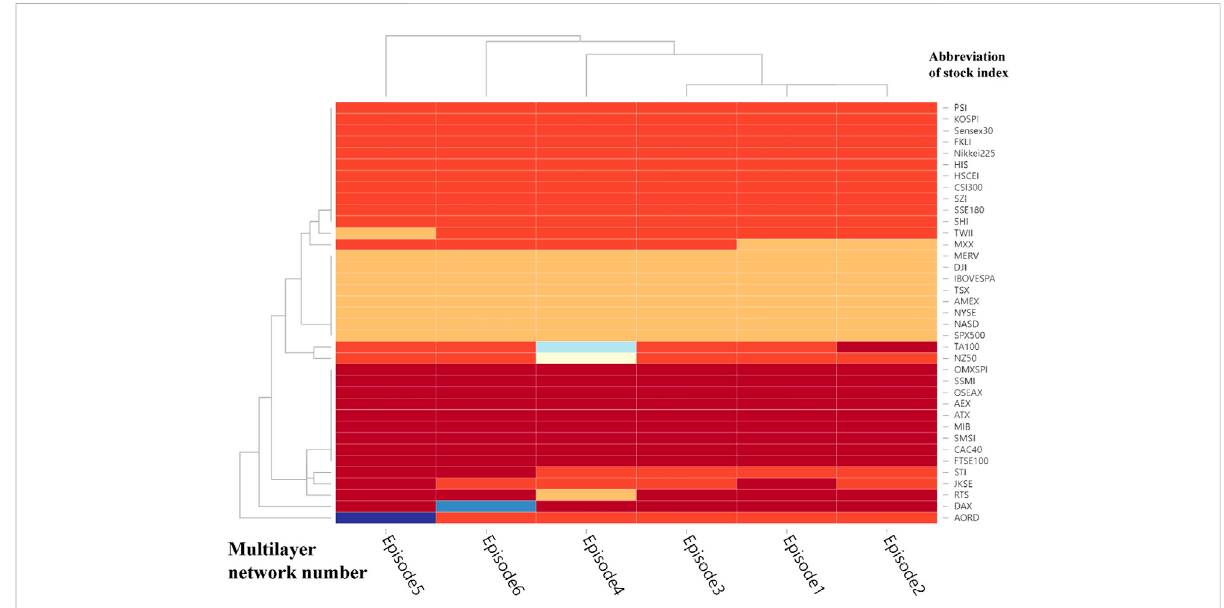
FIGURE 12 Community division results of the multilayer network at the beginning of the European subprime mortgage crisis, obtained by a multi-infomap algorithm.